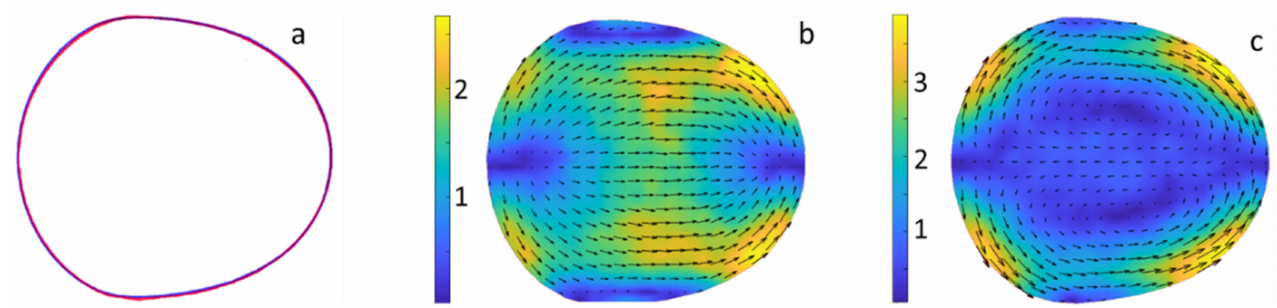
Figure 11. Comparison of C 12 TAB- and Tween-laden drops: ( a ) contours of drops, blue C 12 TAB, 10 mM (0.5 CMC); red Tween 20, 0.6 mM (10 CMC); ( b ) flow field in the middle plane of C 12 TAB drop; ( c ) flow field in the middle plane of